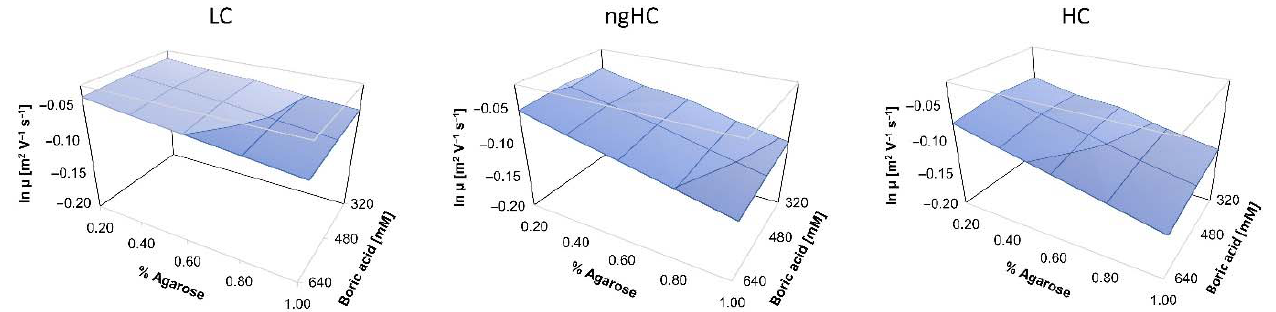
Figure 5. Three ‐ dimensional Ferguson plots for the light (panel LC), non ‐ glycosylated heavy (panel ngHC) and heavy (panel HC) chain subunits of